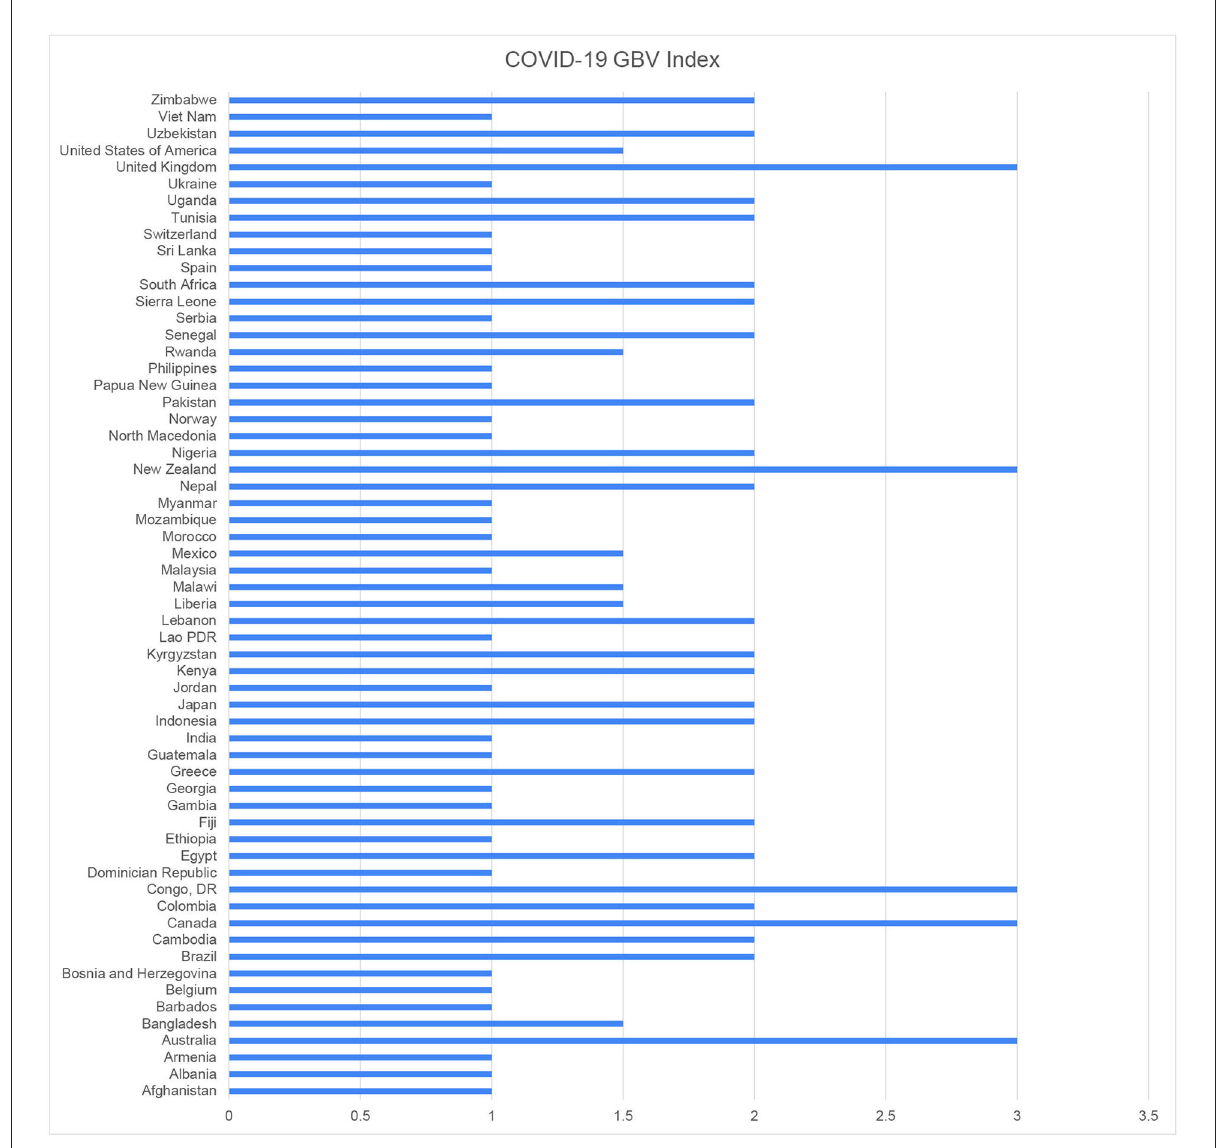
FIGURE1 Government responses to GBV during COVID-19